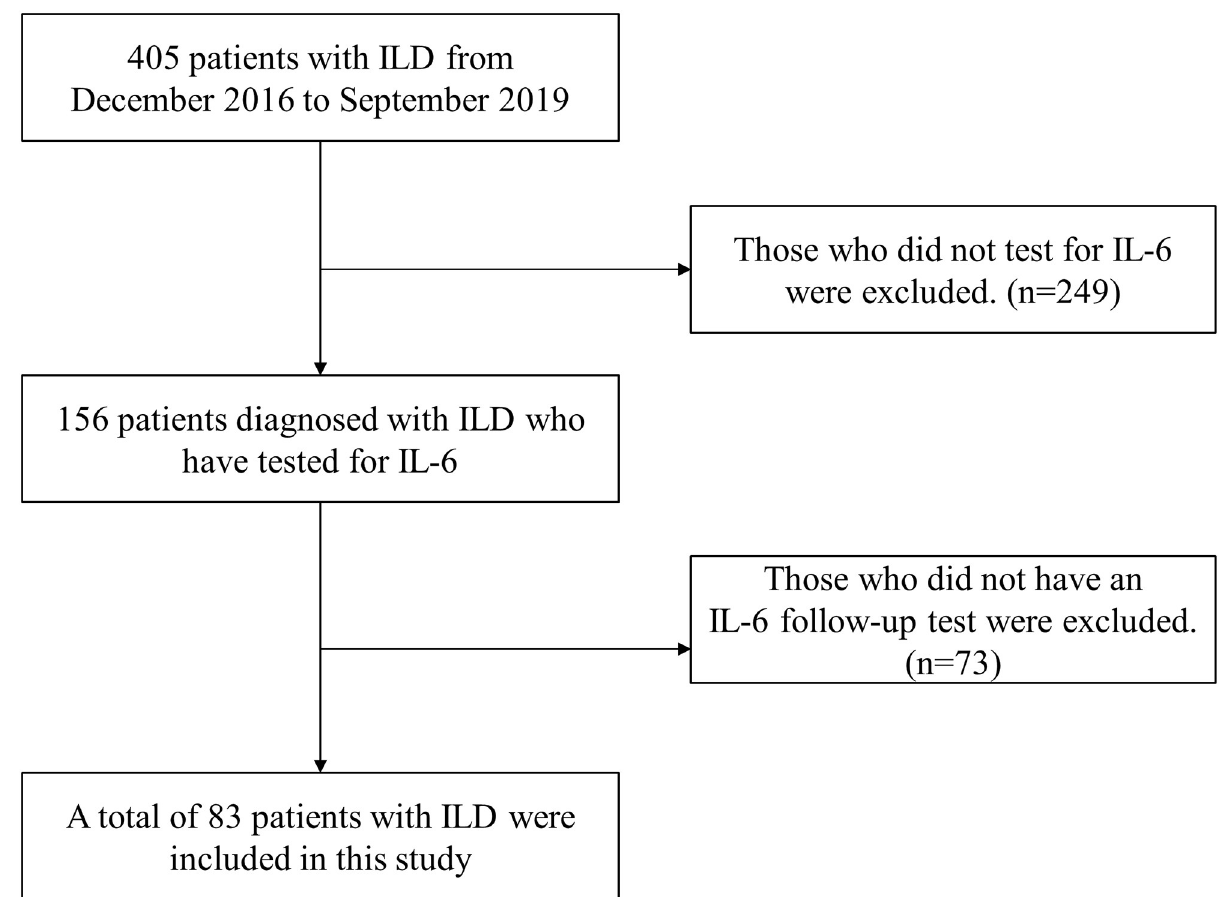
Fig 1. Flow chart of patients enrollment. ILD, interstitial lung disease; IL-6, interleukin-6. level of serum of IL-6 was 14.9 pg/mL. During the follow-up period, 15 patients (18.1%) suf- fered AE. The AE group exhibited higher levels of C-reactive proteins (CRP) and white blood cells (WBC) with lower levels of baseline SpO compared with the no-AE group (Table 2). 2 Predictive factors for AE Among the 15 (18.1%) patients with AE (idiopathic AE: 11 patients and triggered AE: 4 patients), IPF patients were most common (80%) while the other patients were classified with CTD (20%). In the univariable logistic regression analysis, high levels of serum IL-6 during the follow-up period, CRP, white blood cell (WBC) count, lactate dehydrogenase (LDH), baseline (Table 3).